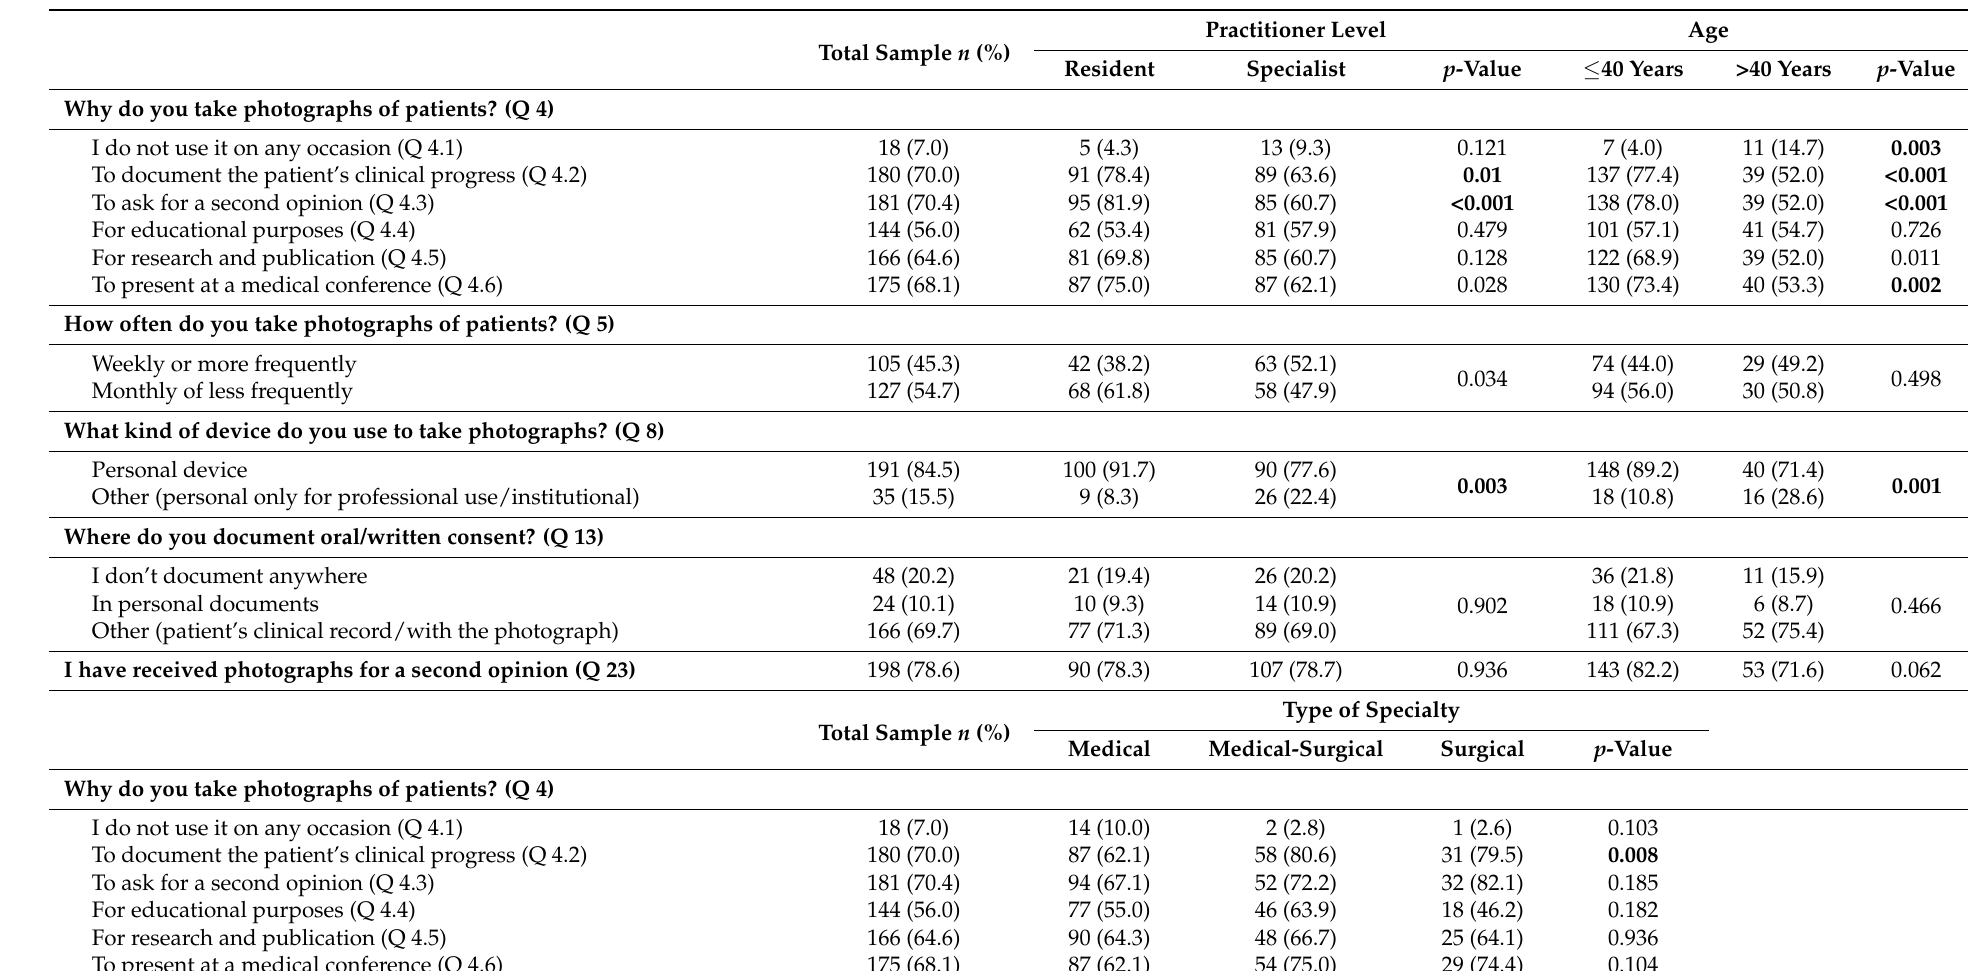
Table 2. Association of sociodemographic variables with questionnaire questions regarding the use of medical